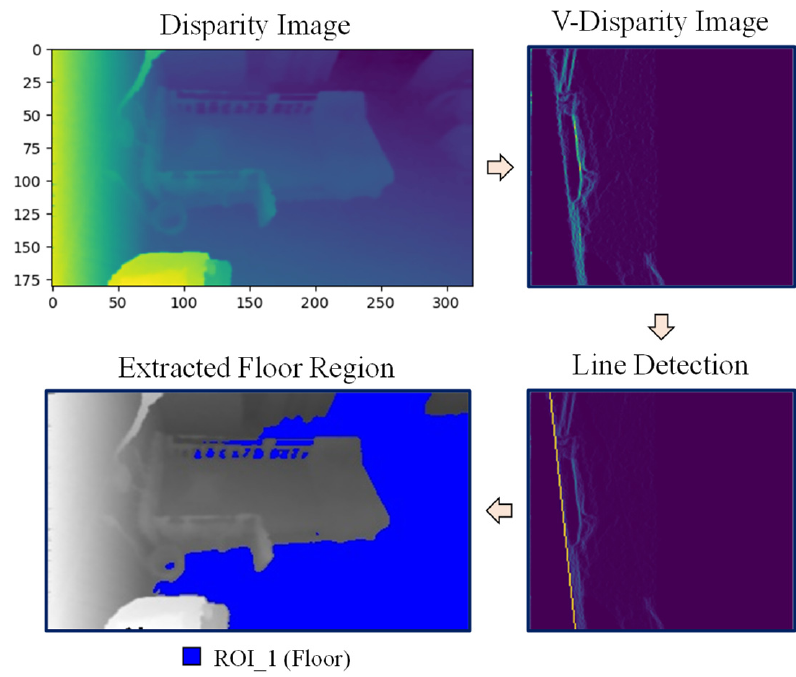
Figure 5. Floor region extraction. After removing floor pixels, the disparity map without floor pixel values is used to extract the bed region, as shown in Figure 6a. The V-disparity map is also used for extracting the bed region, but we will not find a straight line in this approach as the bed surface is not as flat as the floor. Instead, connected component labeling is used to find the label with the largest pixel count in the V-disparity map. The assumption is that the bed has the largest area as compared to other objects in the bedroom. After that, four extreme points (minimum height, maximum height, minimum disparity, and maxi- mum disparity) are extracted from the detected label which has the maximum pixel count. We used these four points to establish the bed pixels. From the minimum to maximum height in the disparity image, the pixels which have disparity values within minimum and maximum disparities are detected as bed pixels. Finally, the detected floor pixels and bed pixels are subtracted from the average background depth image. The remaining pixels are automatically detected as the ignored region as shown in the Figure 6b, in which the three ROI regions are represented by three different colors. After ROI extraction, the pixels belonging to different regions are stored, and pixel intersection is used to locate the person in the room. For instance, if more than 70% of pixels in a blob recognized as a person are located in the bed region, it can be deduced that the person is located on the bed. However, if more than 30% of the blob is located in the floor region, that person is located on the floor. An example of person localization for different frames is shown in Figure 7, in which the color representations for each region are also